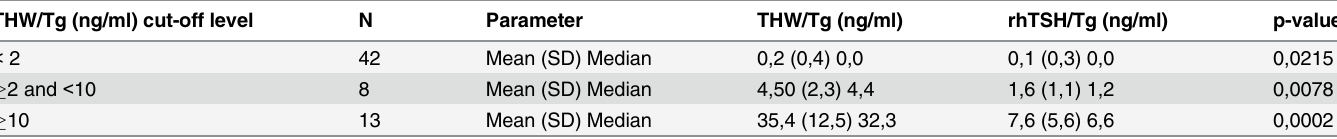
Table 1. Recombinant human thyrotropin-stimulated thyroglobulin (rhTSH/Tg) levels in groups of patients divided in accordance to thyroid hor- mone withdrawal-stimulated thyroglobulin (THW/Tg) cut-off levels. THW/Tg (ng/ml) cut-off level